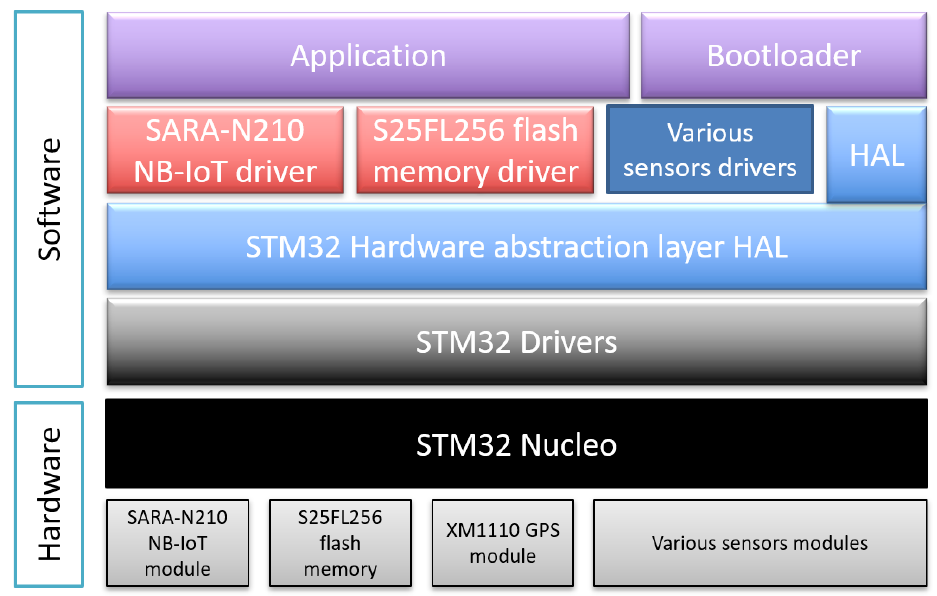
Figure 9. Application and bootloader software